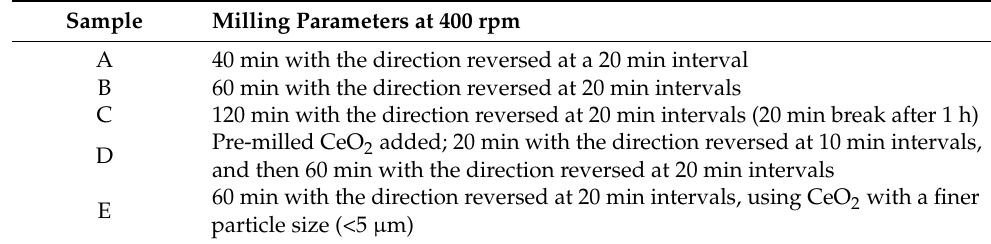
Table 1. A summary of investigated milling